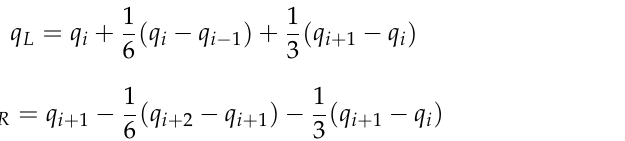
Table 1. The value of the parameters of the modification term 𝑓 (cid:3015)(cid:3006) . Parameter